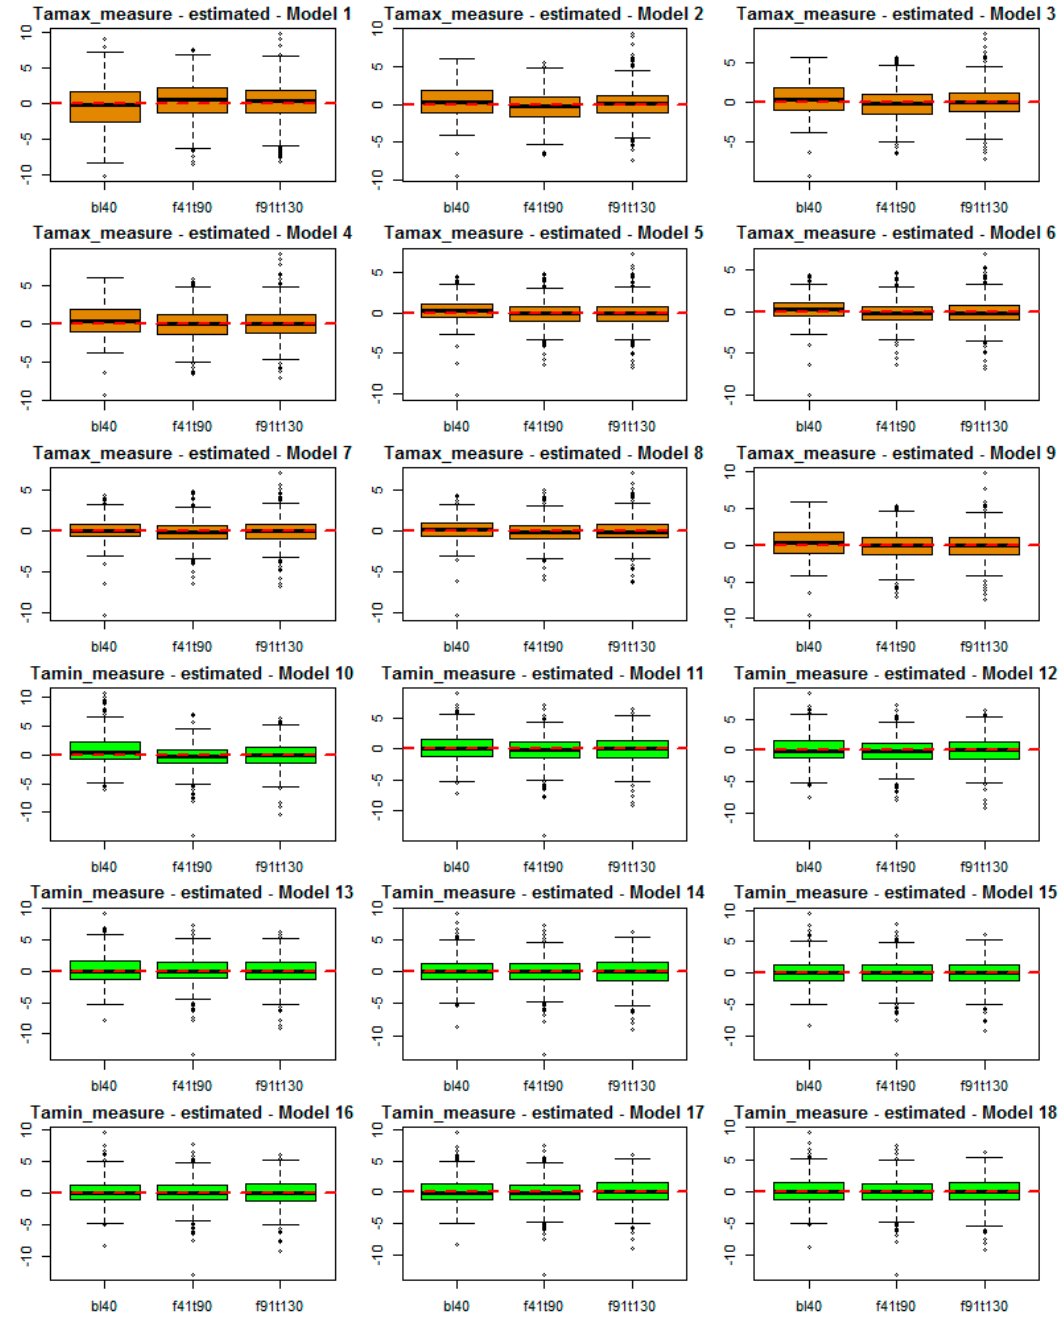
Figure 8. Box-plots with the difference between T a -estimated and T a -measured by the view zenith angle (VZA). The line within the box indicates the median. The bottom of the box is the first quartile, and the top is the third quartile. Whiskers represent the lowest value still within 1.5 IQR (IQR = third quartile − first quartile) and the highest value still within 1.5 IQR. The black plus mark indicates outliers. bl40 (0 ◦ ≤ VZA ≤ 40 ◦ ), f41t90 (41 ◦ ≤ VZA ≤ 90 ◦ ), f91t130 (91 ◦ ≤ VZA ≤ 130 ◦